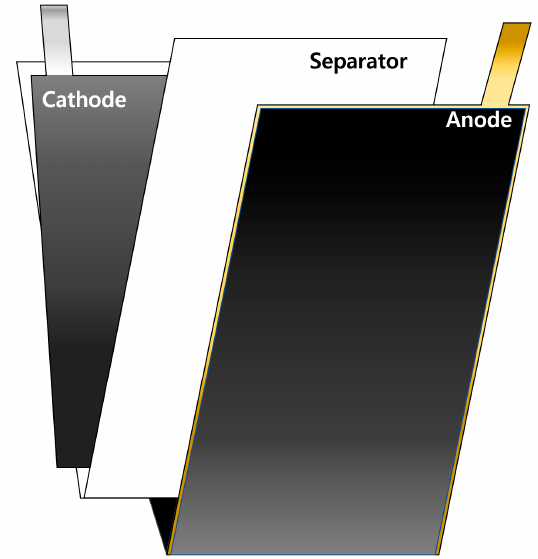
Figure 2. Schematic of the electrode of the SLPC.